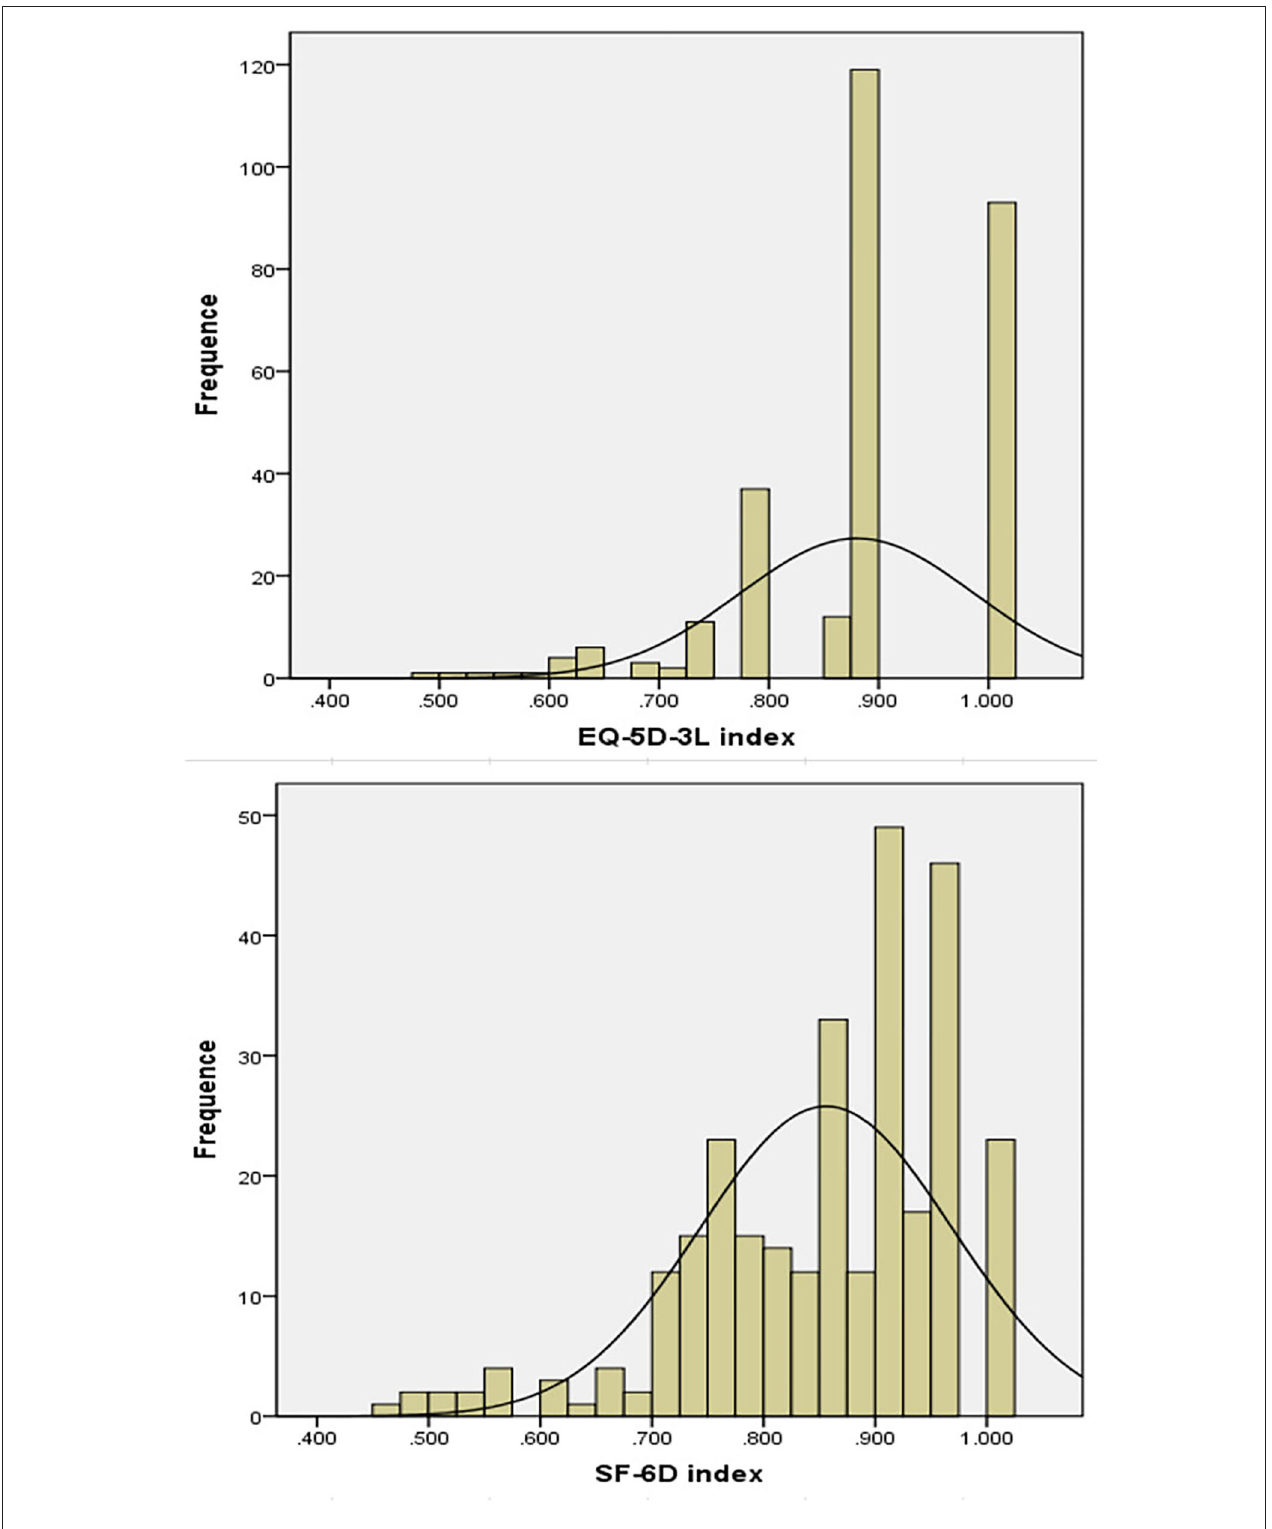
FIGURE 2 | Score distribution of the EQ-5D-3L and SF-6D.